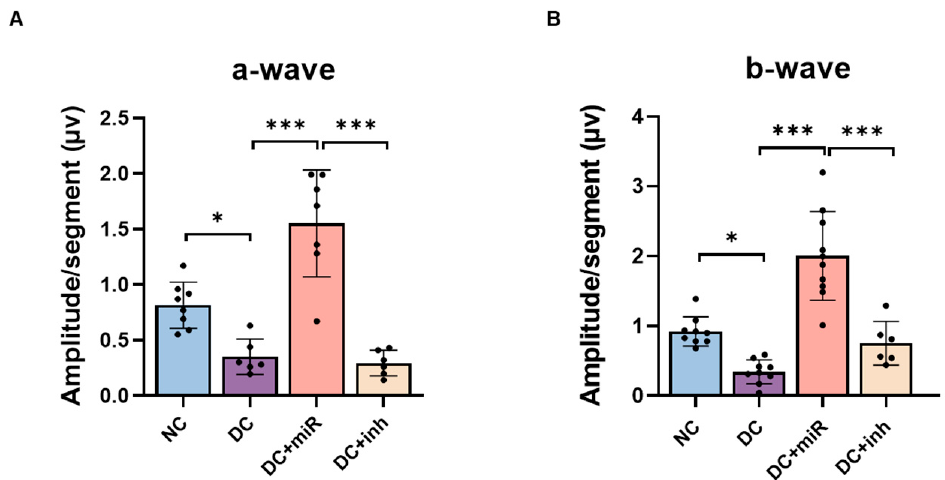
Figure 4. Effects of miR-124 on neuroretinal functions of diabetic rats. ( A ) Averaged values of a-wave amplitudes and ( B ) b-wave amplitudes measured by mfERG on rats at week 24 in four experimental groups: non-diabetic control (NC), diabetic control (DC), diabetic rats treated with miR-124 (DC+miR) or with its inhibitor (DC+inh). Data are presented as mean ± SD, n = 6–8. p values were determined by one-way ANOVA with Tukey’s multiple comparisons test, * p < 0.05, *** p < 0.001. 2.5. miR-124 Suppresses the Inflammatory Responses of Reactivated Microglia in Diabetic Retinae To assess the effect of miR-124 on microglia inflammatory response in persistent hyperglycemic conditions, we examined the expression of inflammation-associated genes in the retinae of NC, DC, DC+miR, and DC+inh rats using quantitative RT-PCR. In contrast to the expression in NC, a large range of inflammatory molecules were notably enhanced in DC retinae, including cytokines ( Tnf- α , Il-1 β ), CD74 molecule ( Cd74 ), chemokines ( Ccl2 , Ccl3 ), vascular cell adhesion protein 1 ( Vcam1 ), Tgf- β 1 , Arg1 , and Il-10 (Figure 5). Importantly, the elevated expression of these genes was specifically inhibited by the introduction of miR-124, which demonstrates the inhibitory effects of miR-124 in the inflammatory responses of microglia in diabetic